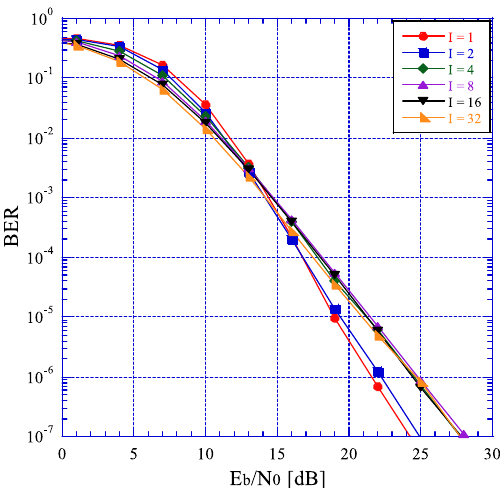
Fig. 12 BER of the various E b / N 0 for the interleaved block subcarrier allocation with the DFT, the MMSE, and the coding